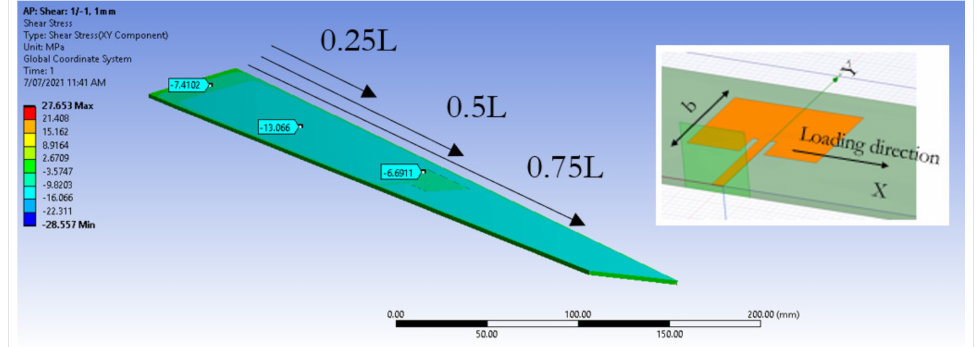
Figure 14. Deformed structure with embedded patch antenna under twist loading, with three positions indicating tested antenna locations.